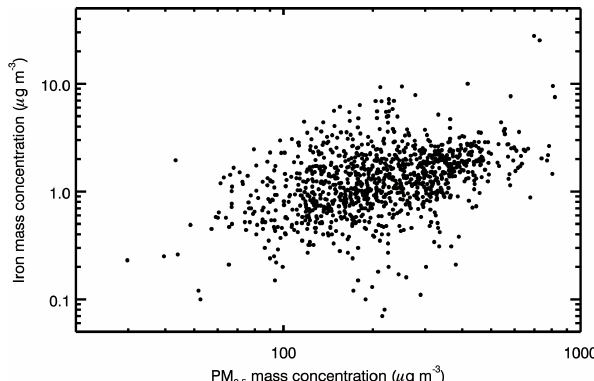
Figure 4. Scatter plot of the observed relative humidity with sulfate mass concentrations at the IEECAS site in Xi’an during the winter- time from 2003 to 2011.